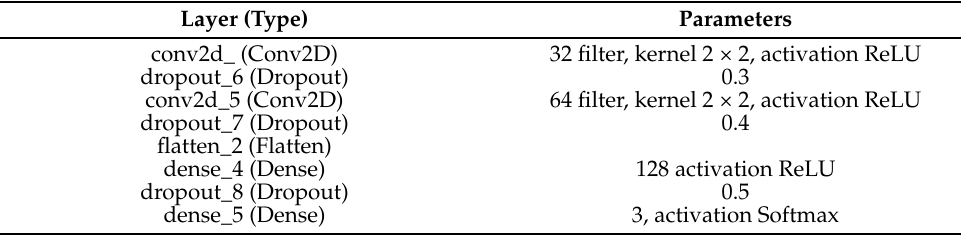
Table 3. Characteristics of the CNN